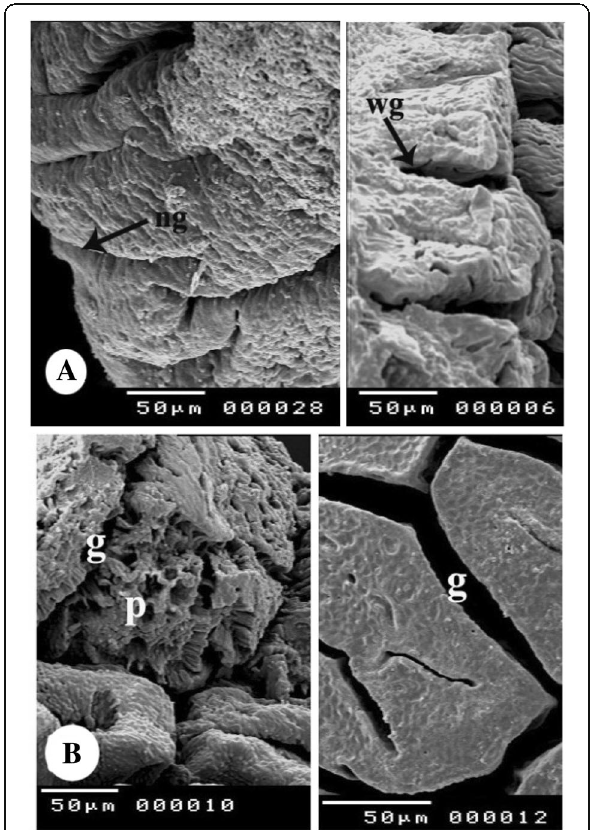
Fig. 4 A , B Scanning electron microscope of the foot of Monacha obstructa showing A unexposed snails; the foot sole (left) with many narrow grooves (ng), and the sides (right) with many wide grooves (wg). B Snails exposed to UV-A for 3 h for 2 days; the grooves became